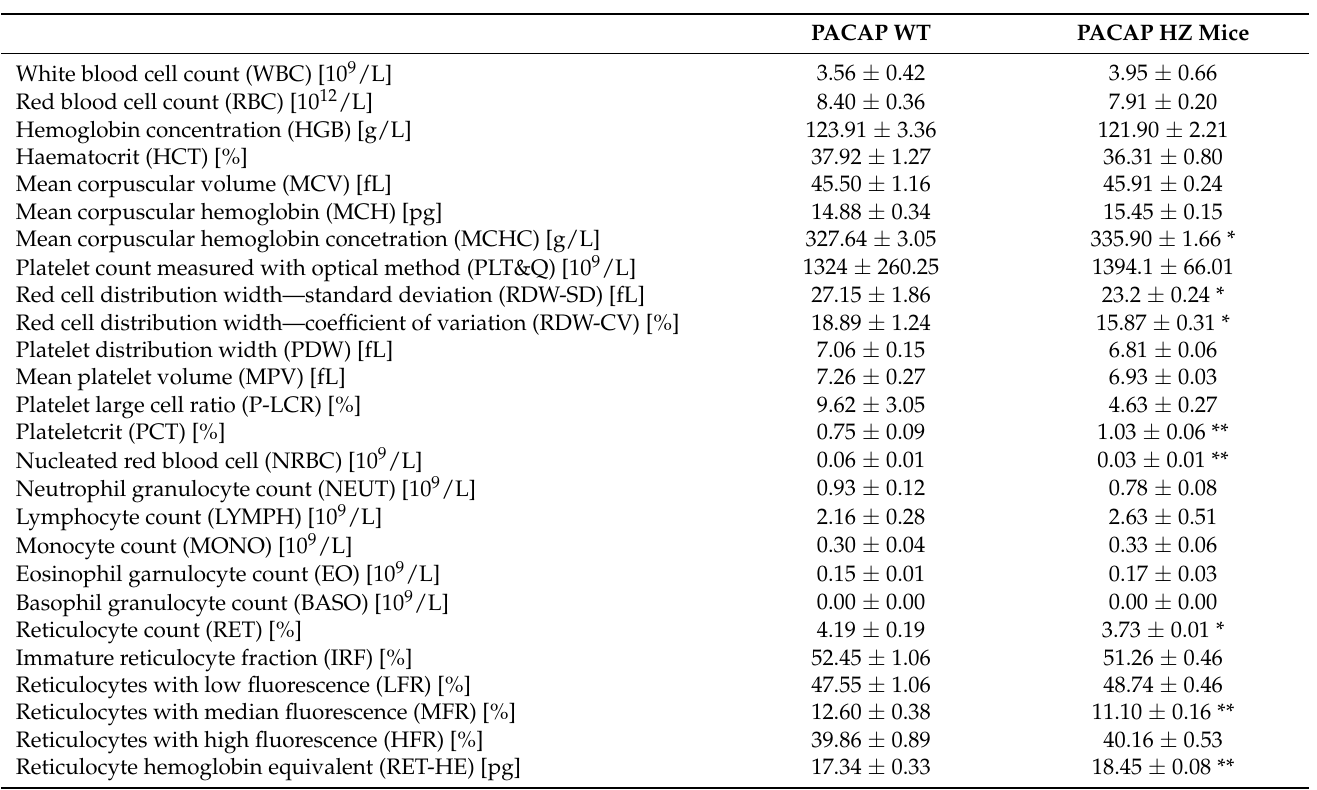
Table 2. Blood count in wild type (WT) and PACAP heterozygous (HZ) mice. Results are given in mean ± S.E.M. * p < 0.05, ** p < 0.01 compared to wild type